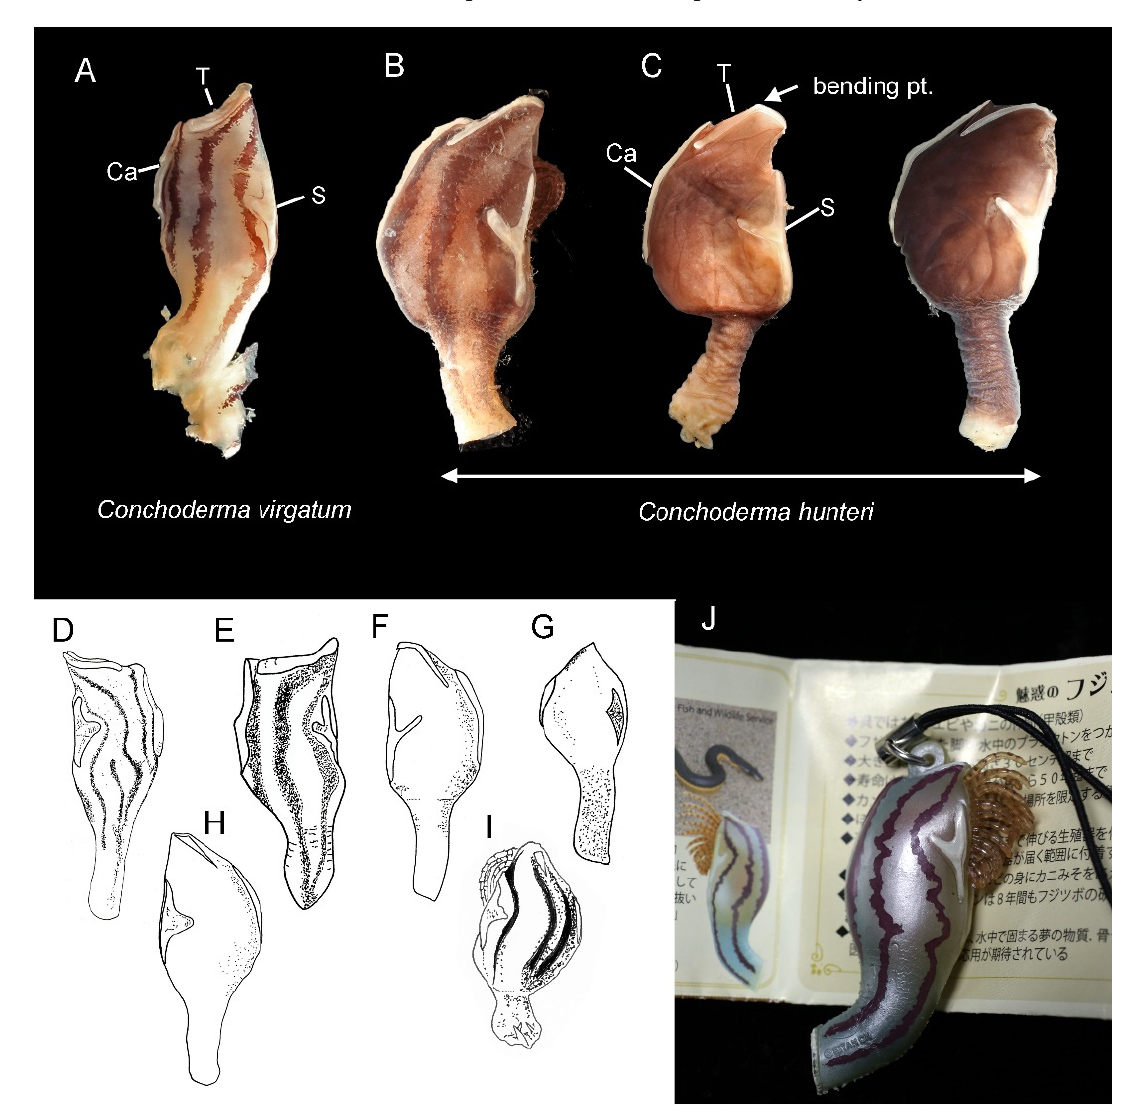
Figure 1. ( A ). Conchoderma virgatum , showing the capitulum with three longitudinal dark bands. ( B ). Conchoderma hunteri , specimen with faint dark bands on the capitulum. ( C ). Conchoderma hunteri with pale brown ( left ) and darker brown ( right ) capitulum. Note tergum bends at the distal 1/4 portion. ( D ). C . virgatum , redrawn from Darwin (1851) [7]. ( E ). C . virgatum redrawn from Pilsbry (1907) [15]. ( F ). C. hunteri , redrawn from Darwin (1851) [7]. ( G ). C . indicum redrawn from Daniel (1953) [12]. ( H ). C . chenolophilum redrawn from Darwin (1851) [7]. ( I ). C . chenolophilum redrawn from Hoek (1883) [16]. ( J ). A Japanese plastic key chain of C . virgatum and with its biological descriptions.